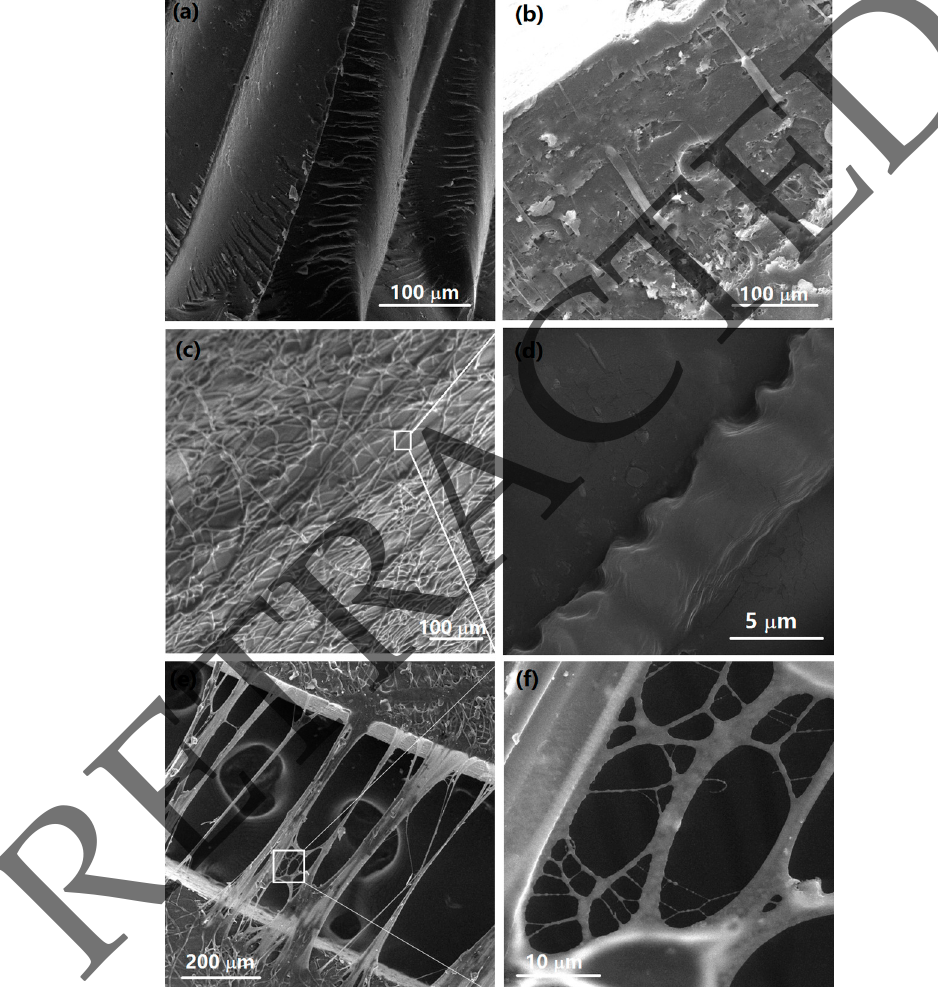
Figure 7. SEM images of fracture surface in tensile mode: ( a ) the fracture surface of neat epoxy resin; ( b ) the fracture surface of E-ERF 10 resins; ( c , d ) the top surface of E-ERF 10 resin; ( e ) bridging zone of E-ERF 10 resin; ( f ) nanoweb formation in bridging zone.